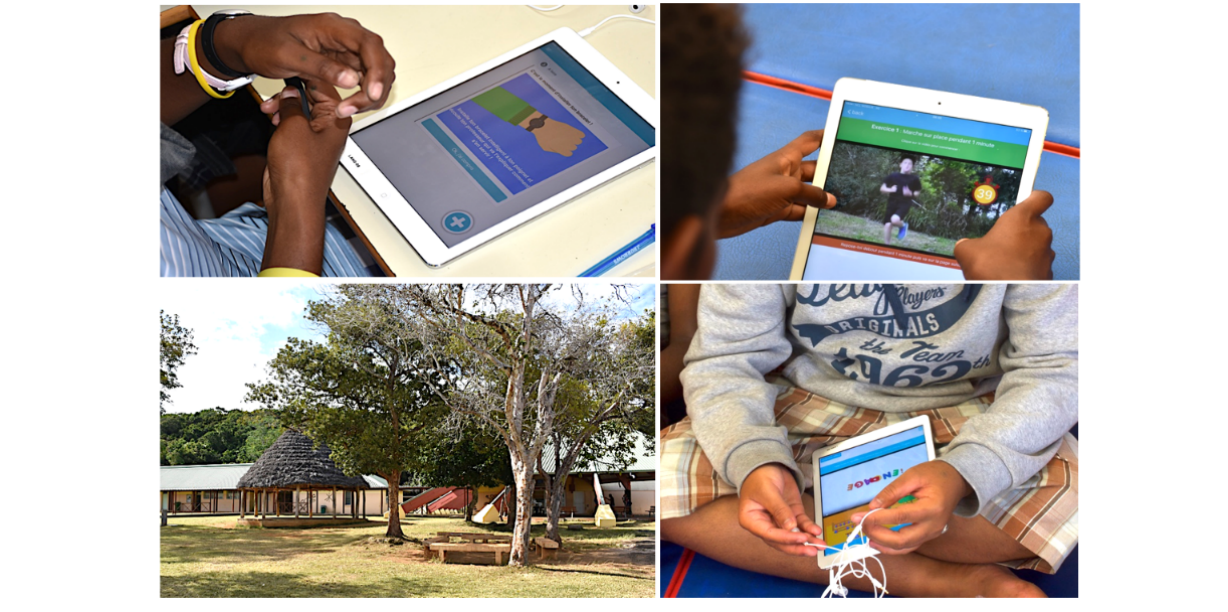
Figure 2. App screenshot and pictures of children in activity during